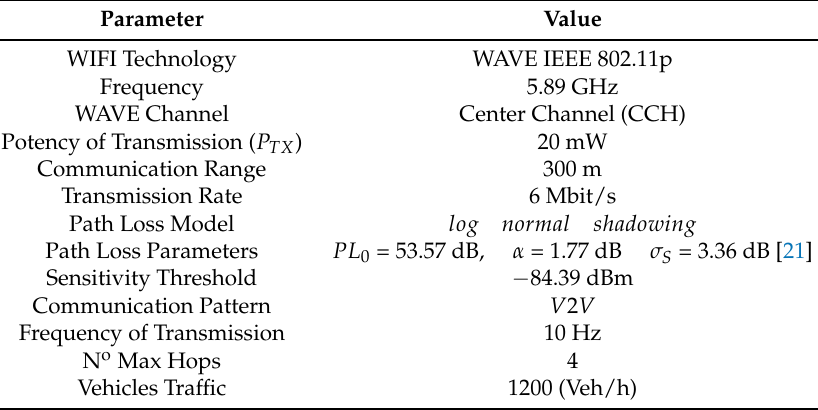
Table 5. Vehicular network